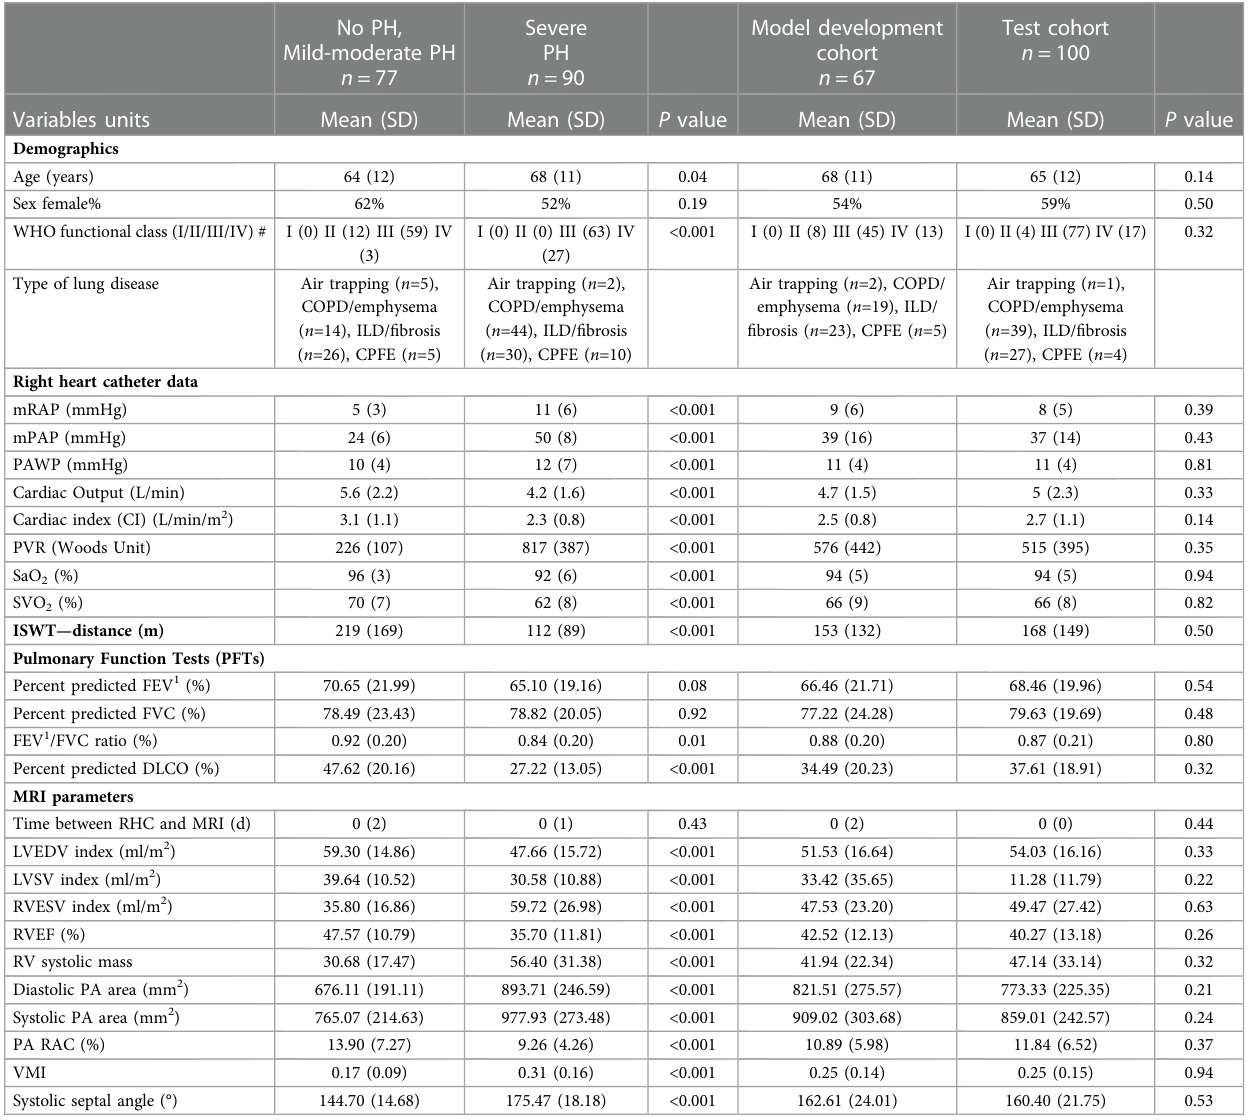
TABLE 1 Baseline demographics for all patients according to PH status and derivation or test